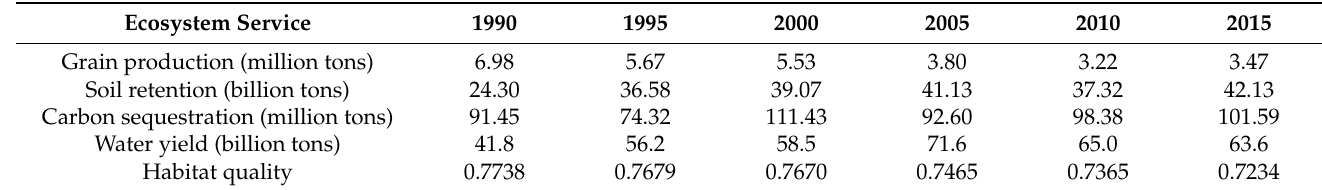
Table 4. Different ecosystem services in the Pearl River Delta from 1990 to 2015.